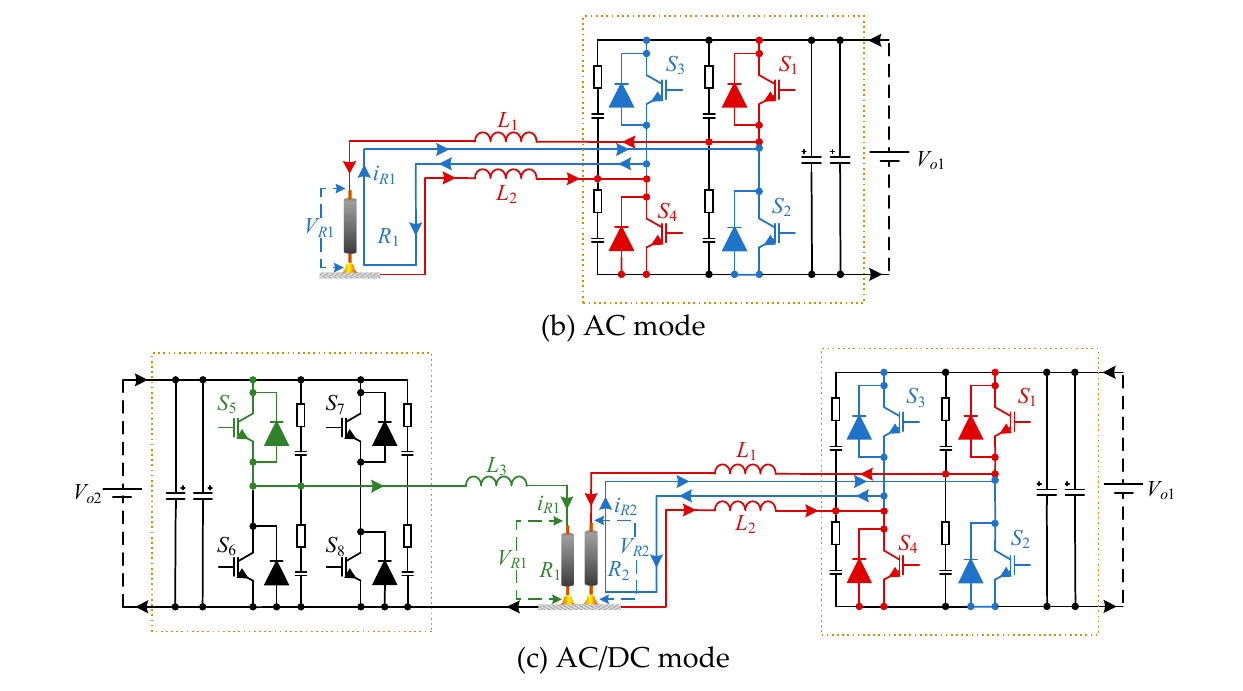
Figure 7. Chopper converter working principles.